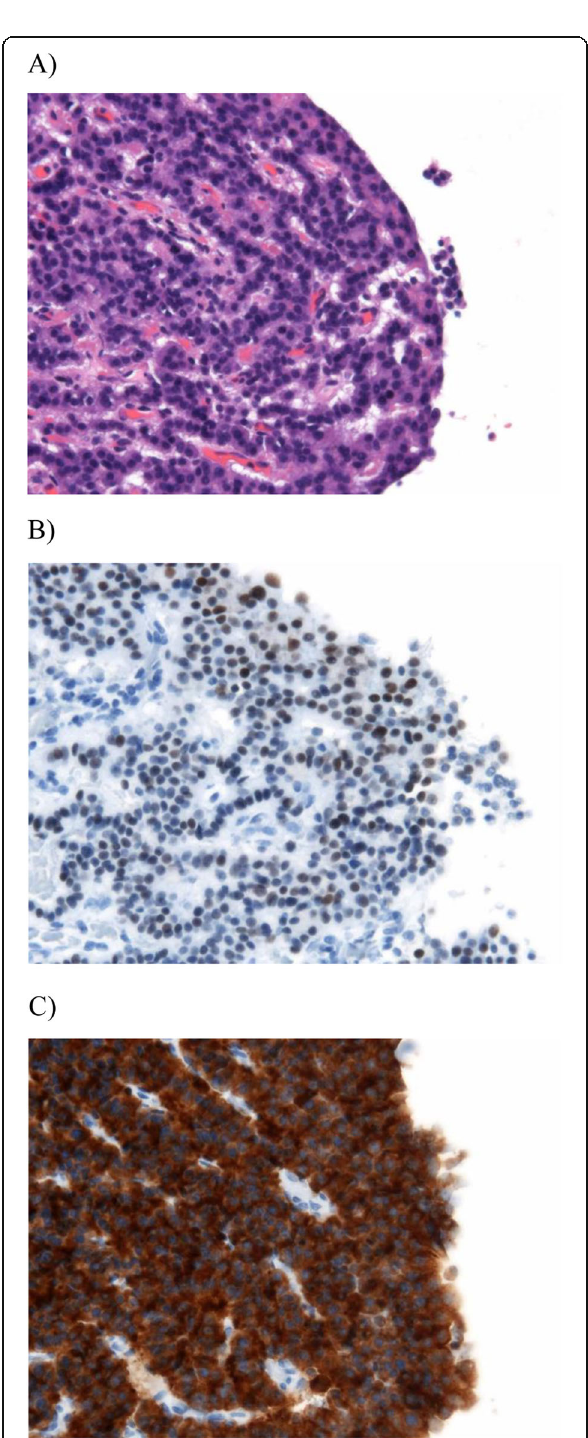
Fig. 6 Histopathological findings for the resected pancreas. a Tumor cells had ribbon-like hyperplasia and gland-like structures. There were small blood vessels around the cells and no mitotic figures at 10 hpf (hematoxylin and eosin staining). b and c Tumor cells showed positive results for INSM1 ( b ) and synaptophysin ( c ) by immunohistochemical